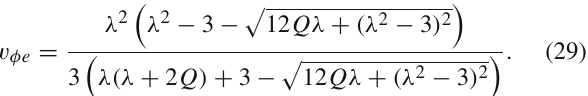
Table 4 Eigenvalues and stability of the fixed points for the quintessence field with Q (ρ φ + ρ m )